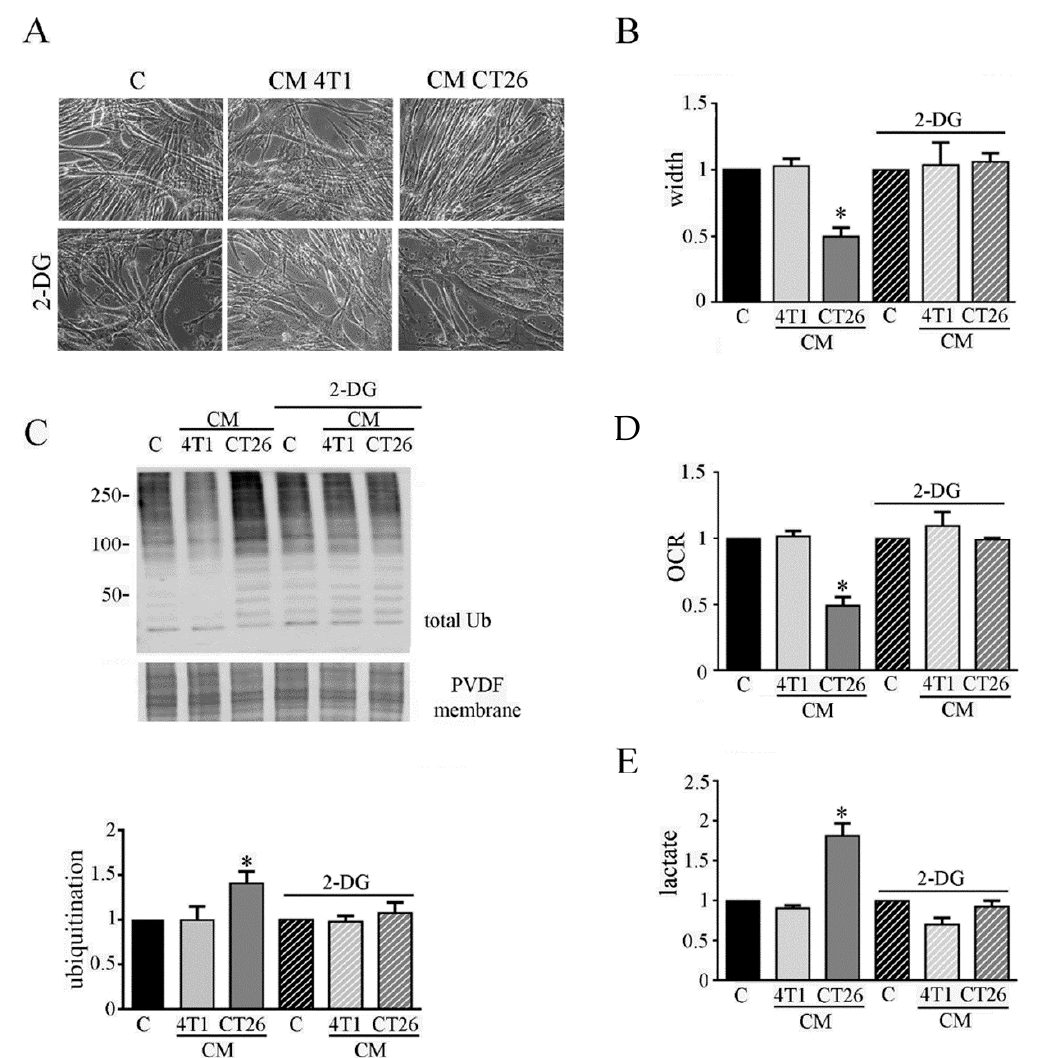
Figure 2. Inhibition of glycolysis impairs cachexia in myotubes. Four days-differentiated myotubes were treated with CM 4T1 or CM CT26 or differentiating medium (C, control) for 24 h. Where indicated, 2-deoxy-glucose (2-DG) (1 mg/mL final) was added to media. ( A ) Representative optical microscope images of treated myotubes with or without 2-DG. Scale bar: 100 µm. ( B ) Measure of myotube width 24 h after the treatment. ( C ) Ubiquitination level of myotubes. Total ubiquitination level reported in the bar graph was obtained by using Coomassie-stained PVDF membrane for normalization. ( D ) Analysis of oxygen consumption rate (OCR). ( E ) Assay of lactate amount in myotubes. All the values in the bar graphs are reported as fold increase, considering control myotubes as 1; n = 4; * p <